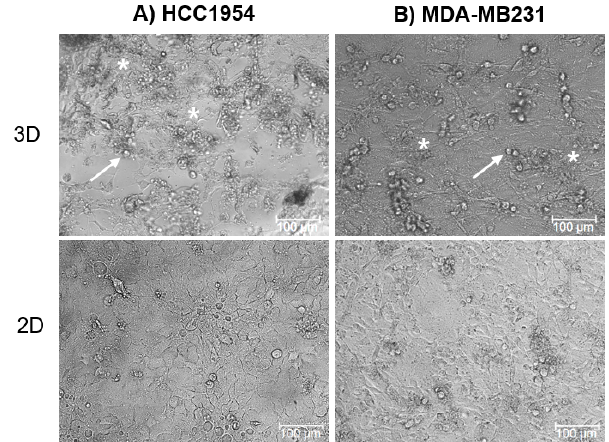
Figure 1. Cell morphology in 3D and 2D cultures. HCC1954 ( A ) and MDA-MB231 ( B ) 3D and 2D cell culture images acquired in a bright field. White arrows indicate cells, whereas white stars indicate the extracellular matrix deposed by cells. Data are from triplicate wells for each condition in two independent experiments. Scale bar 100 µm. Magnification 20×.